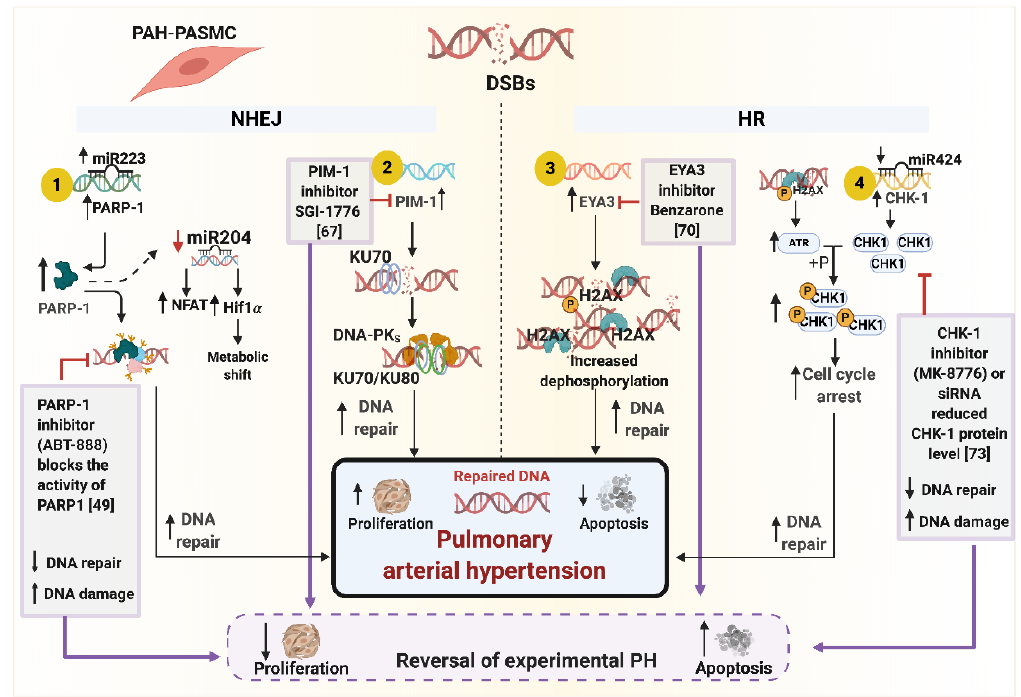
Figure 3. Dysregulated DNA damage response genes involved in pro-proliferative and apoptosis resistance characteristics of PAH-PASMCs. The figure represents the DDR genes and their downstream pathways implicated in PAH pathogenesis (1) PARP-1, (2) PIM-1, (3) EYA3, and (4) CHK1. These genes are upregulated in PAH-PASMCs leading to increased DNA repair and proliferation and reduced apoptosis. Studies have shown specific pharmacological inhibitors like ABT-888 (PARP1 inhibitor), SGI-1776 (PIM1 inhibitor), Benzarone (EYA3 inhibitor), and MK-8776 (CHK1 inhibitor) downregulate their target genes, leading to reduced proliferation and increased apoptosis, suggesting their therapeutic potential in PAH. DSBs, Double-stranded breaks; NHEJ, Non-Homologous End Joining; HR, Homologous Recombination; DSBs, Double-strand breaks; PARP1, Poly (ADP-Ribose) Polymerase 1; PIM1, Proto-Oncogene Serine / Threonine Kinase; EYA-3, Eyes Absent Homolog 3; CHK-1, Checkpoint Kinase 1; KU70, X-Ray Repair Cross Complementing 6; KU80, X-Ray Repair Cross Complementing 5; NFAT, Nuclear Factor of Activated T-Cells; HIF1 α , Hypoxia-Inducible Factor 1- α ; H2AX, H2a Histone Family Member X; P, phosphoryl group; ATR, Ataxia Telangiectasia and Rad3-Related Protein; miR223, microRNA 223; miR204, microRNA 204; miR424, microRNA 223; DNA-PKs, DNA-Dependent Protein Kinases; PAH, Pulmonary Arterial Hypertension. The numbers represented in square brackets cite the reference for that study. Created with BioRender.com.